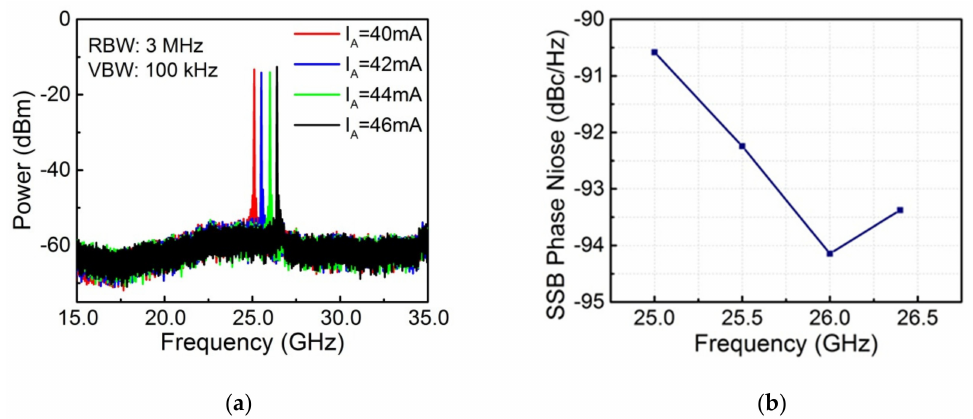
Figure 6. The OEO’s ( a ) RF spectrum; ( b ) SSB phase noise at the 10 kHz o ff set from the carrier frequency, with I A varied from 40 mA to 46 mA, when V PD , I DFB, and I Phase were fixed at − 2.5 V, 75 mA, and 1.5